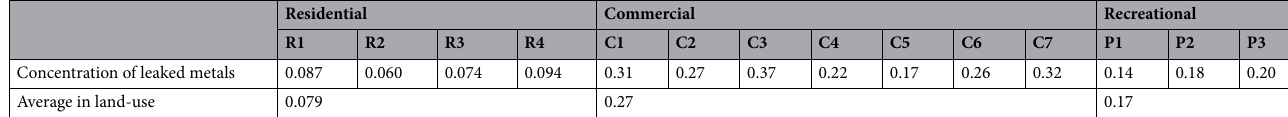
Table 5. Estimation of heavy metal leakage in warm season (μg/m 2 ).